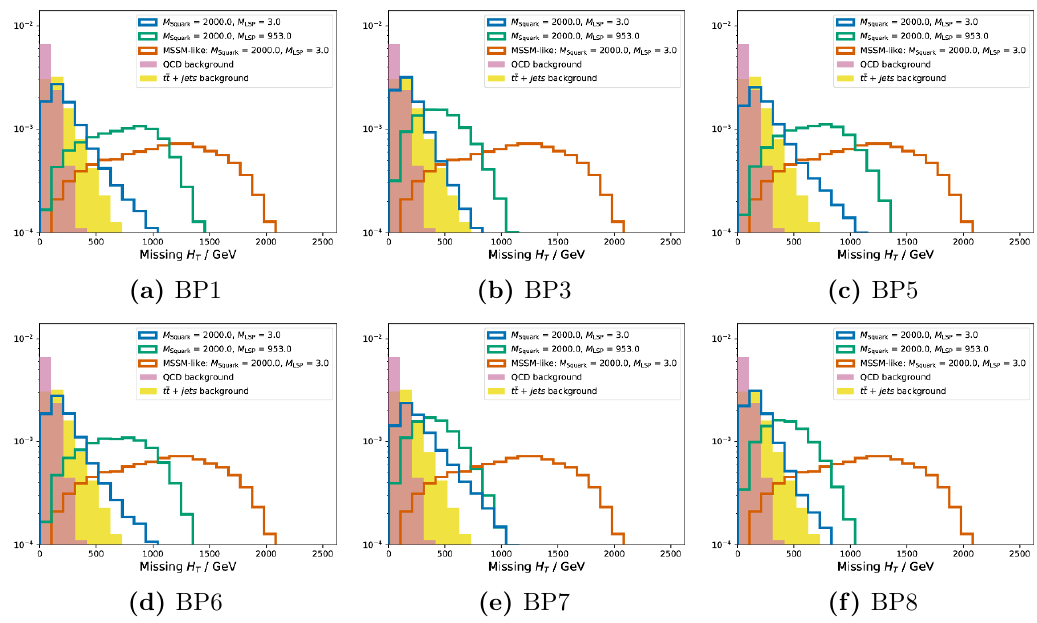
Figure 7. H miss distributions for low and mid-range M LSP near the observed limit in the BP1-type T scan, compared with QCD and t (cid:22) t background